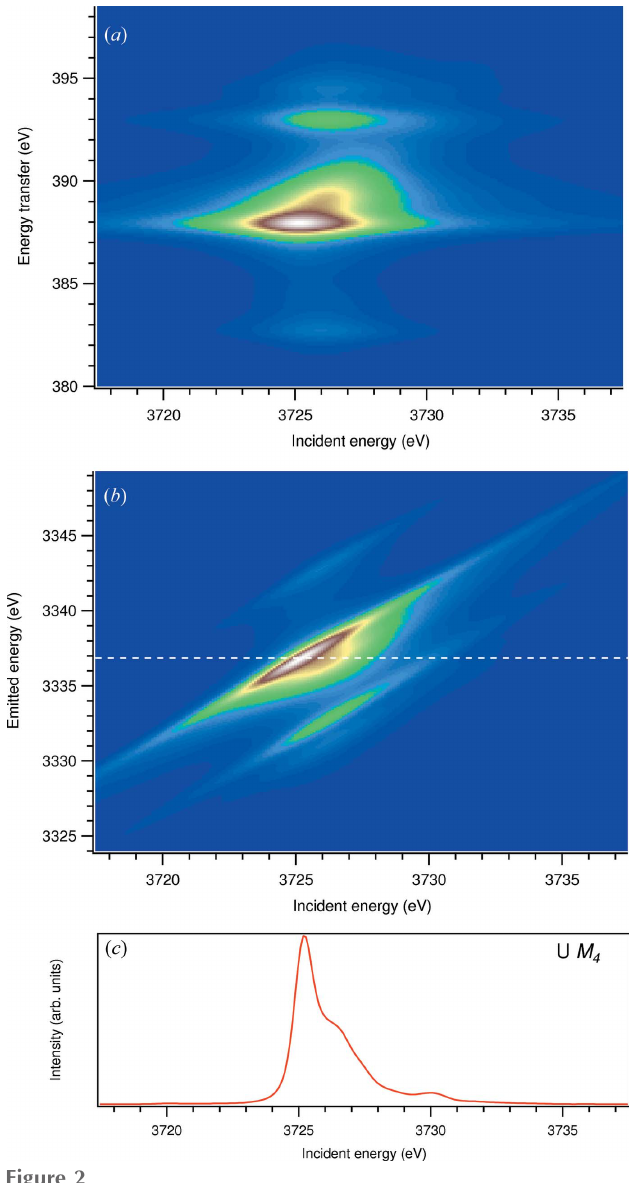
Figure 2 The 3 d –4 f RIXS map of UC with the incident energy on the x axis and the energy transfer ( a ) or emitted energy ( b ) on the y axis. The incident energy varies across the U M 4 edge. Panel ( c ) shows a HERFD cut (red curve) of the 3 d -to-4 f RIXS map along the incident energy axis at an emitted energy corresponding to the RIXS maximum. This cut is indicated by a dashed line in ( b